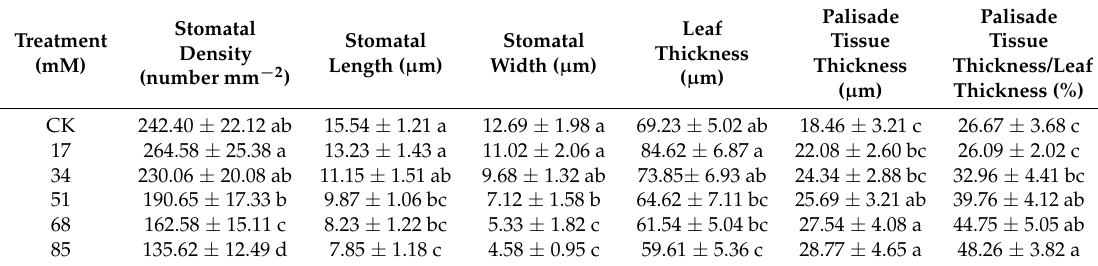
Table 3. Effects of various salinities on the leaf stomatal density, stomatal length, stomatal width, leaf thickness, palisade tissue thickness, and palisade tissue thickness/leaf thickness of Carpinus turczaninowii L. after 42 days.